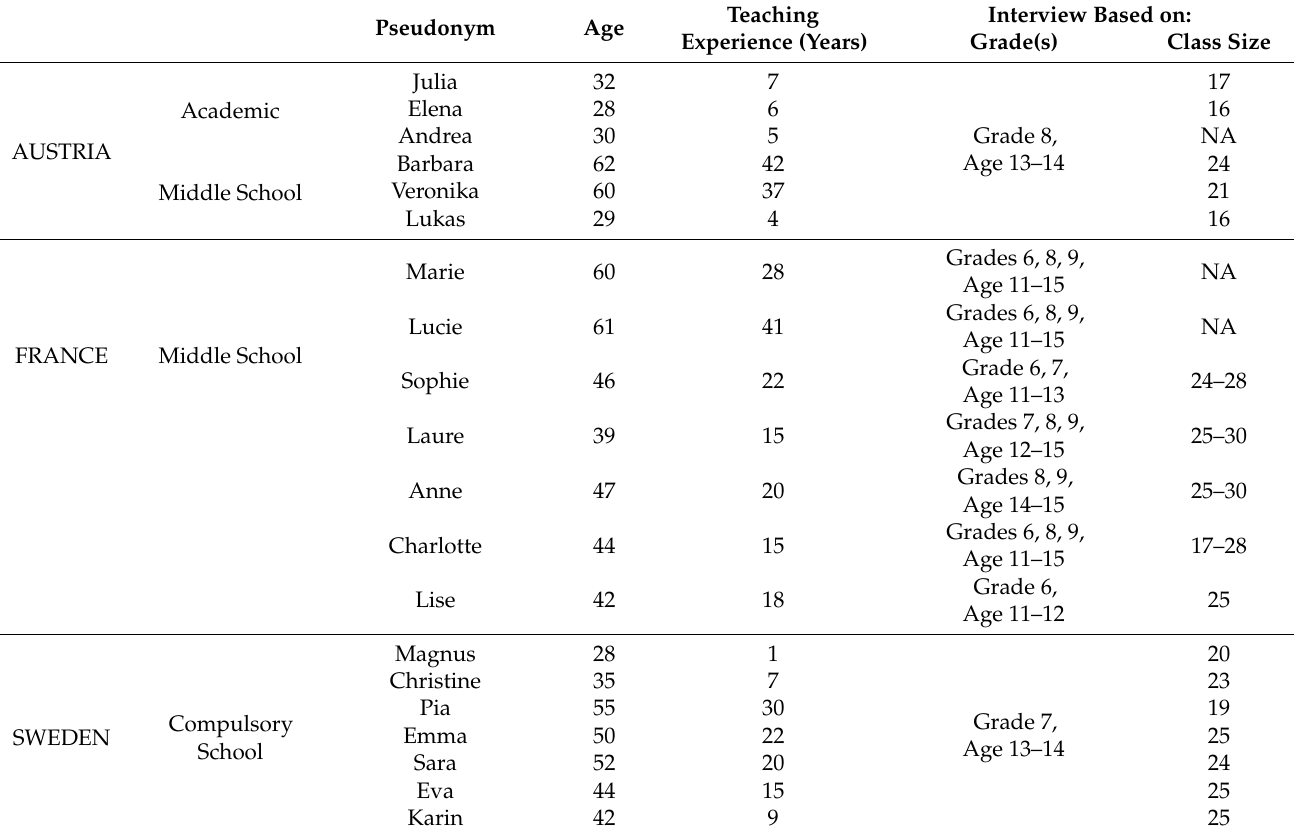
Table 1. Overview of the teacher sample, adapted from Schurz and Coumel